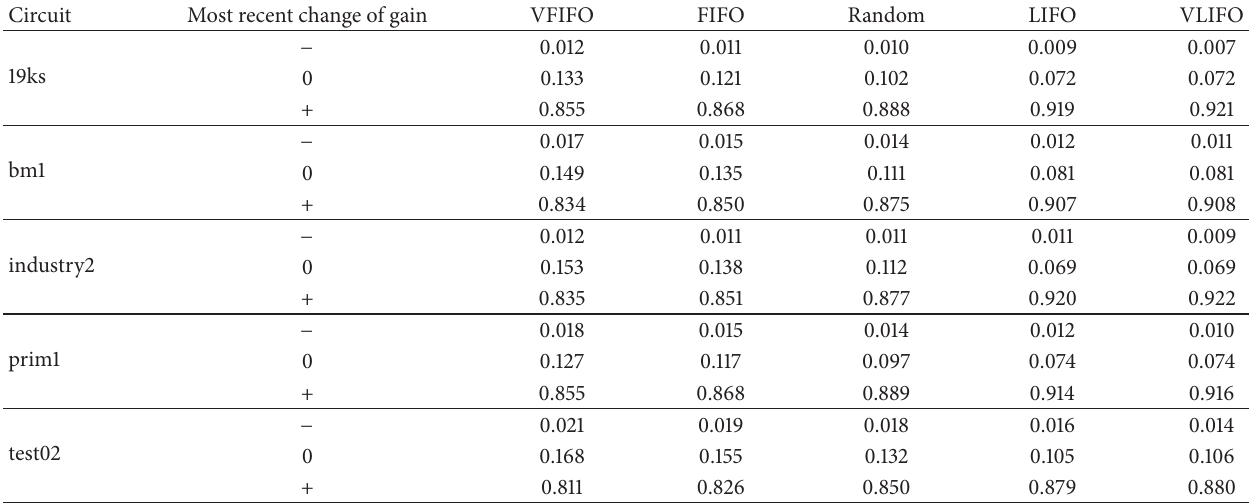
Table 3: Proportion of modules selected which have just had their gain reduced, or increased, for the five choice strategies and five test circuits (average of 1,000